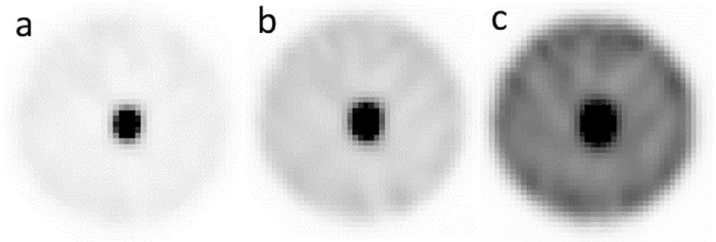
Fig. 4 Capsule and background composite images. Uniform background generated by Poisson resampling the uniform background data: a 11.5 kBq/ml (25% resampling), b 23 kBq/ml (50% resampling) and c 46 kBq/ ml (100% resampling)